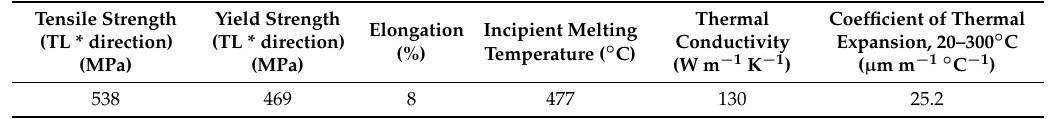
Table 2. Selected physical and mechanical properties of AA7075-T6 [21].